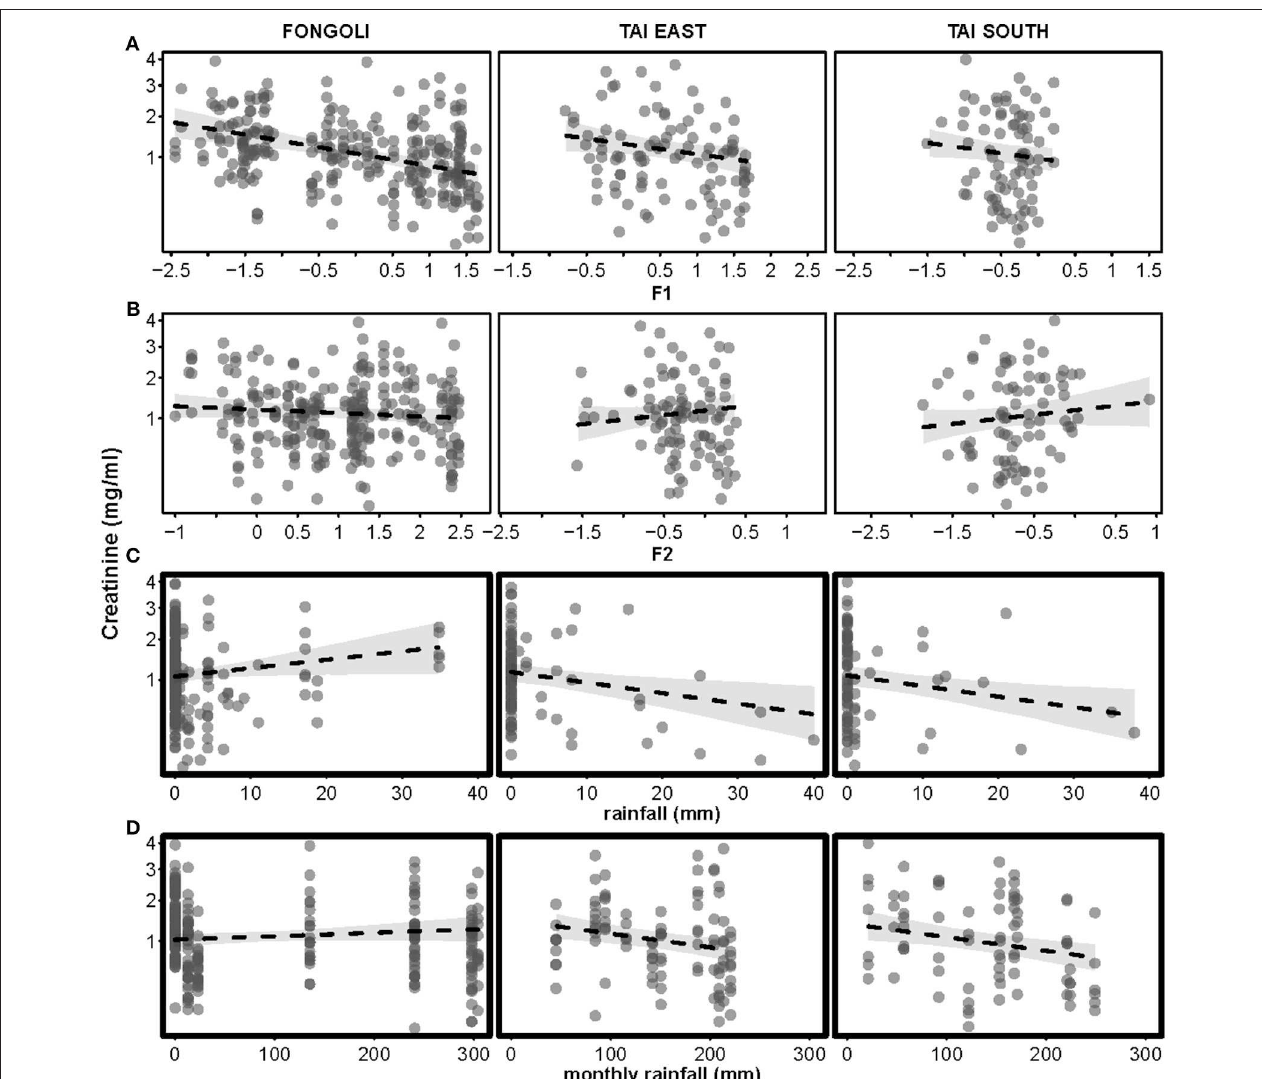
FIGURE 5 | Effects of four environmental variables on urinary creatinine levels in three chimpanzee communities. Environmental variables displayed are: Factor 1 (relative humidity, centered to site; (A) , Factor 2 (temperature, centered to site; (B) , rainfall (C) , and monthly rainfall (D) . Creatinine levels appear on a square-root scale. Statistically significant inter-site differences ( p ≤ 0.05) appear with bold margins; 95% confidence intervals are displayed in gray.